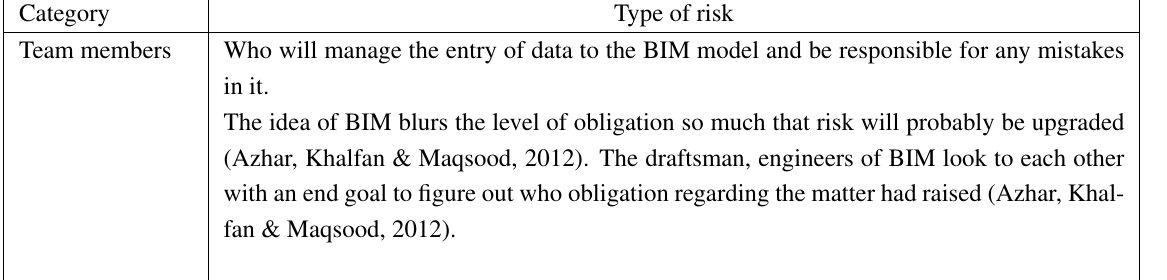
Table 1. building information modeling risks